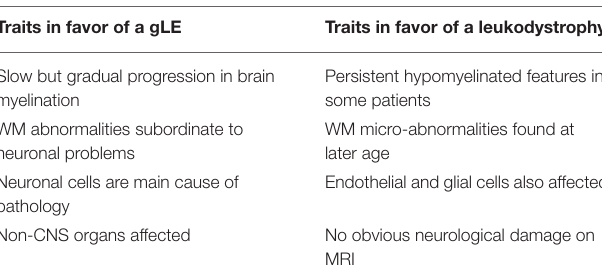
TABLE 2 | Characteristics of AHDS to classify it as a genetic leukoencephalopathy (gLE) vs. a